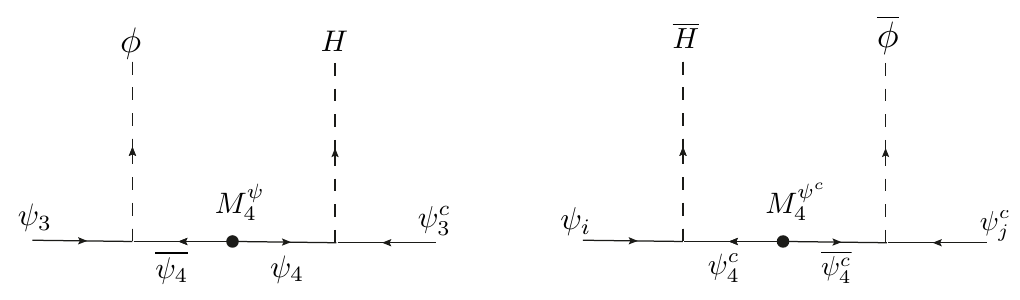
Figure 2 . Diagrams which lead to the effective Yukawa couplings of the third family (left panel) and second family (right panel) where i, j = 2 , 3 are the only non-zero values. In the right panel, we have dropped the distinction between φ and φ 0 for